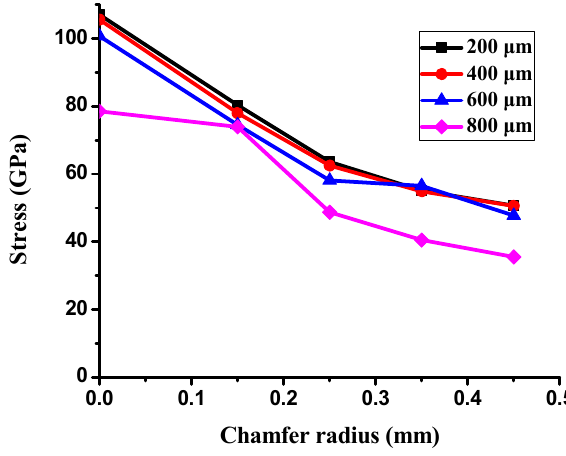
Figure 22. Stress vs. chamfer radius and shoulder width.